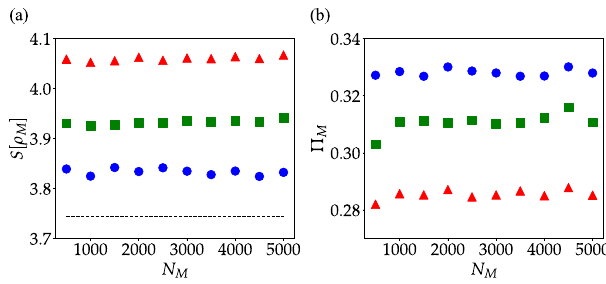
Fig. 3 Thermodynamic limit convergence of cavity effect on the local molecular density of states entropy and excited-state survival probability. a Entropy of molecular LDOS as a function of N M for systems with equal Ω R and varying intermolecular distances a = 10 nm (blue circles), a = 25 nm (green squares) and a = 50 nm (red triangles). The dashed line gives the entropy of the bare molecular LDOS. In all are given in the text. (b) Molecular return probabilities for the same systems. Each data point corresponds to an average of over